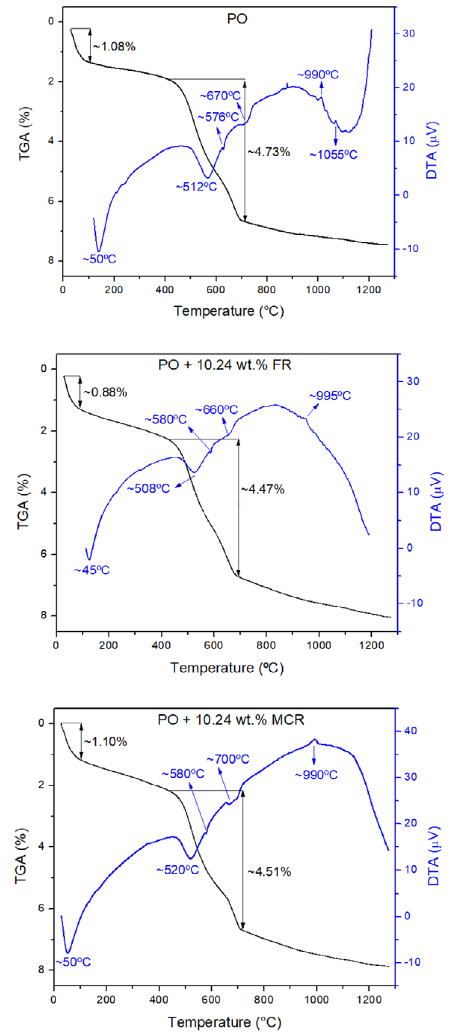
Figure 2. Thermogravimetric analysis (TGA) and differential thermal analysis (DTA) of the porcelain ceramic mass and compositions with 10.24 wt.% of quartzite residues, FR and